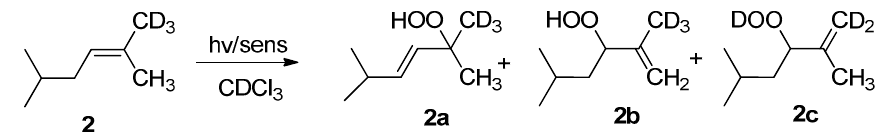
Table 1. Photooxidation of alkyl trisubstituted alkene 2 with TPP and CD-C 3 N 4 . Entry Photocatalyst Regioselectivities (%) b